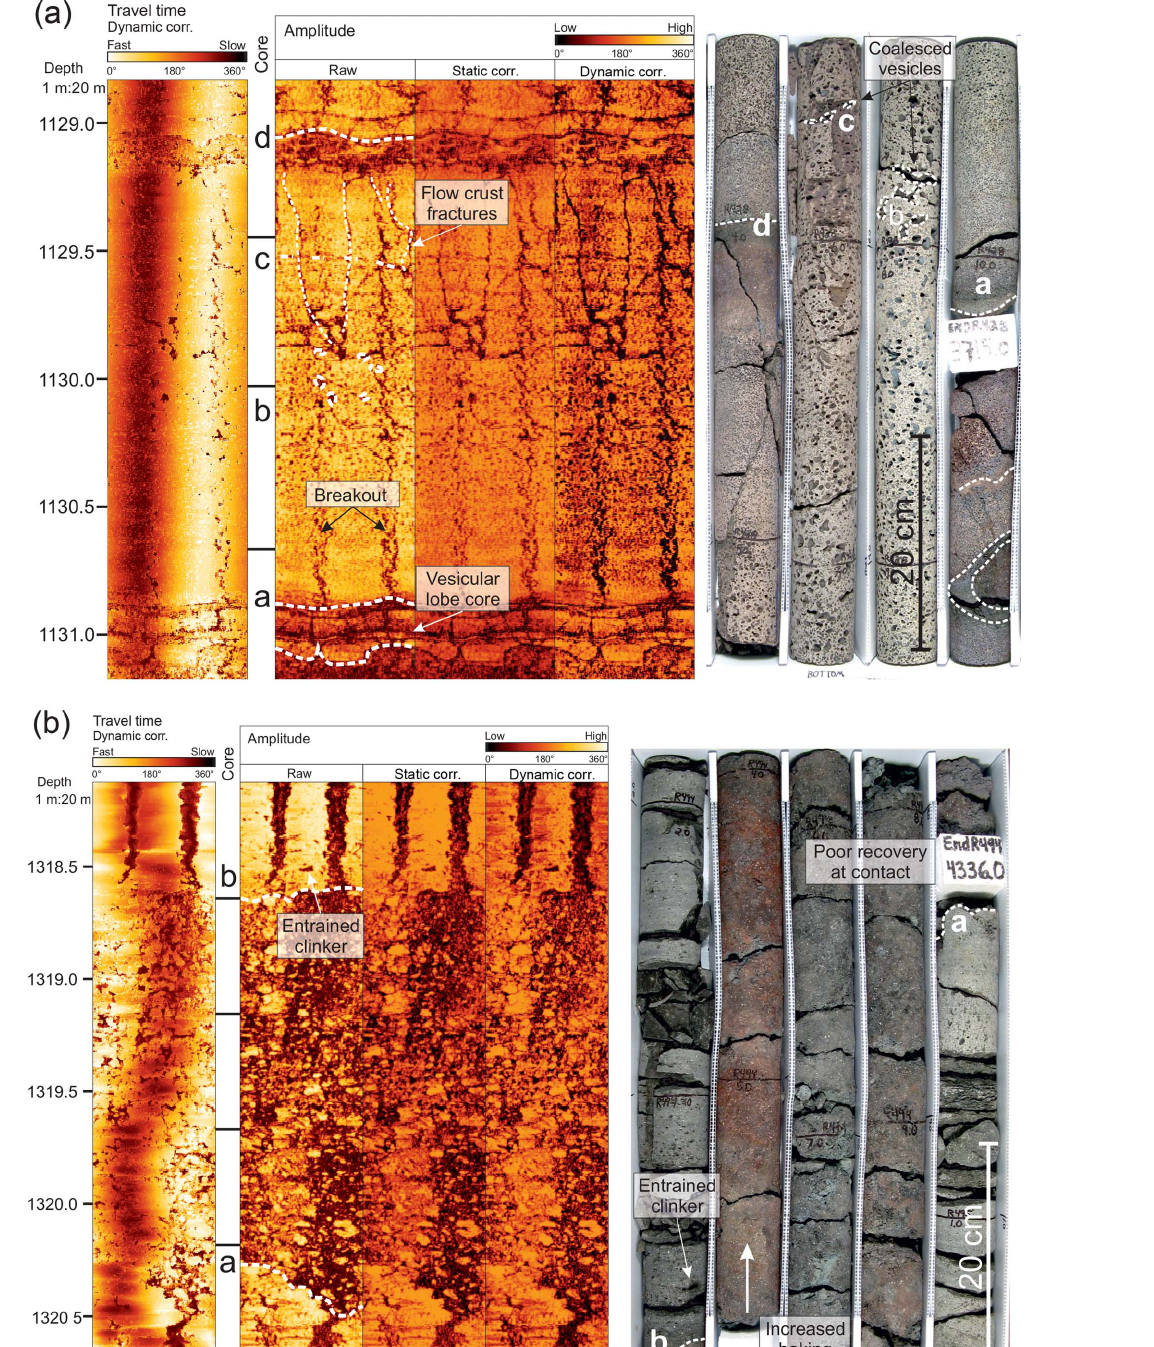
Figure 9. (a) Example of a simple p ¯ ahoehoe lobe from PTA2 displaying characteristic vesicle size distribution clearly imaged from the televiewer amplitude data along with flow top fractures. (b) Detail of a baked ‘a‘¯a flow margin breccia from PTA2. Note the detail at the flow margins is clearer from the televiewer data due to the crumbly nature of the contact rubble. In each image, letters (a, b, etc.) highlight linked features on both the core and the image